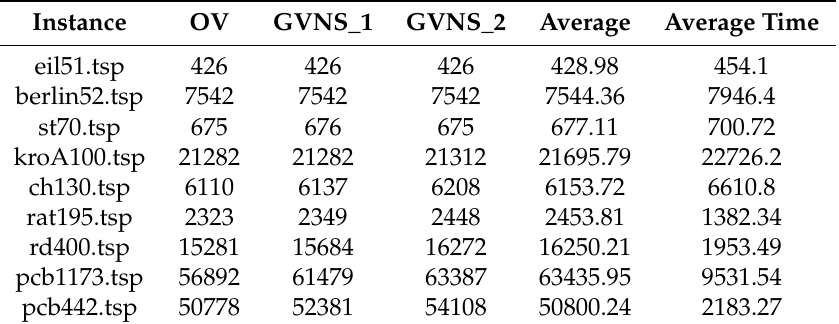
Table 19. Comparisons between GVNS_1 and GVNS_2 with BI for 2 mins with the recent VNS work of Hore et al.